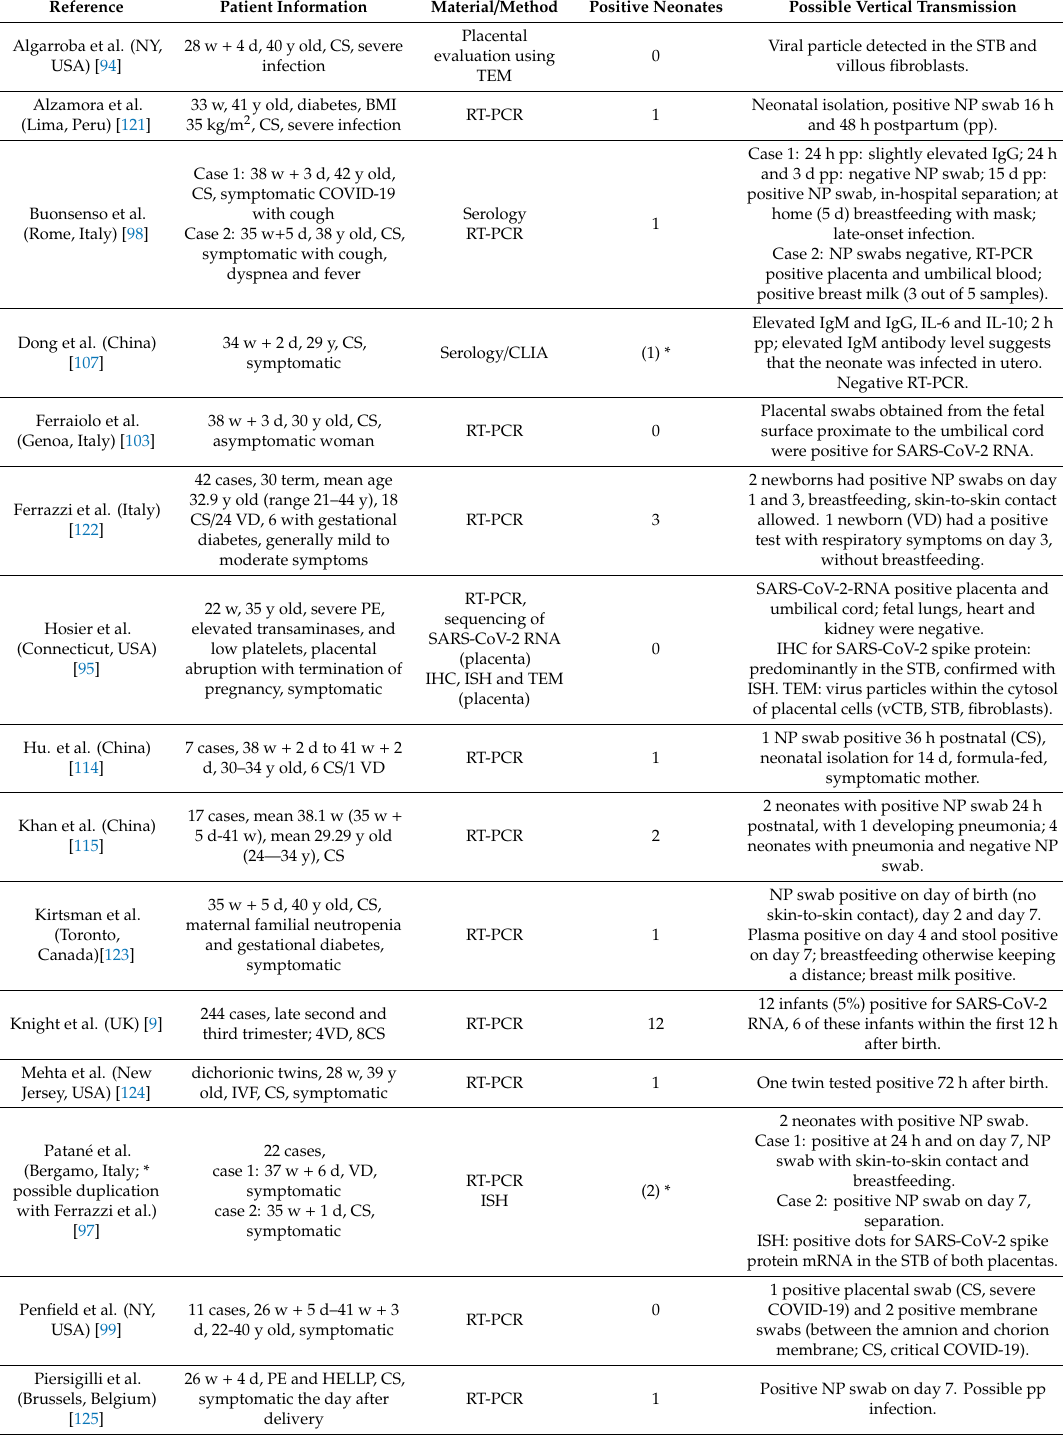
Table 2. Potential evidence of vertical transmission from pregnant women with COVID-19. 35 cases with SARS-CoV-2 positive newborns (RT-PCR) are identified, whereby we cannot exclude a possible duplication of 13 cases with positive RT-PCR tests reported from Wuhan, China [114–120].